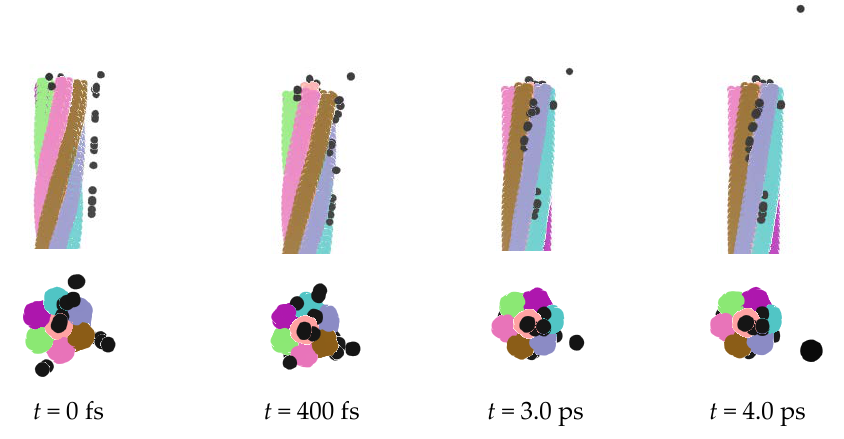
Figure 2. Adsorption of metal ions.